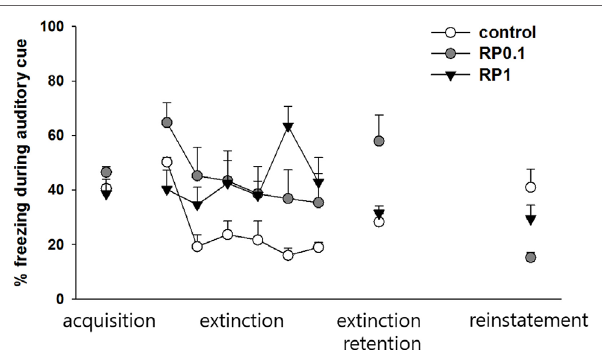
FigUre 3 | The effect of Radix Polygalae (RP) on cued fear memory acquisition, extinction, extinction retention, and reinstatement. The average % freezing of eight sessions (acquisition) or five sessions (extinction, extinction retention, and reinstatement) are plotted. Repeat measure analysis of variance (ANOVA) showed within-group (procedure) effect [ F (2.9, 79.4) = 9.1, p < 0.001, η 2 = 0.253] and within–between group interaction [ F (5.9, 79.4) = 6.8, p < 0.001, η 2 = 0.336] but no between-group (treatment)